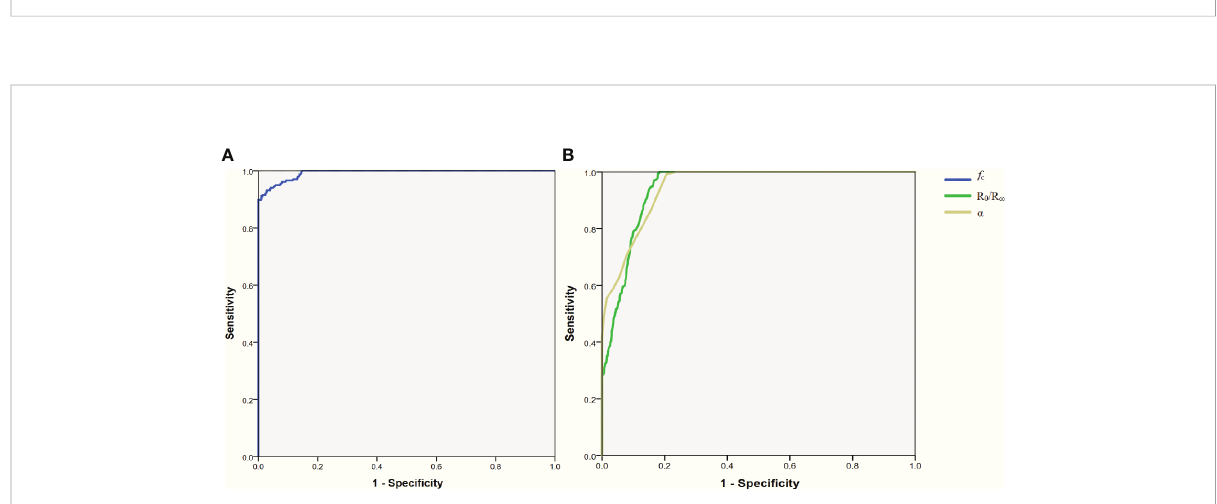
FIGURE 3 ROC curve for the parameters of Bioelectrical Impedance Spectroscopy. (A) parameter of f c . (B) parameter of R 0 /R ∞ and a . ROC receiver operating characteristic.